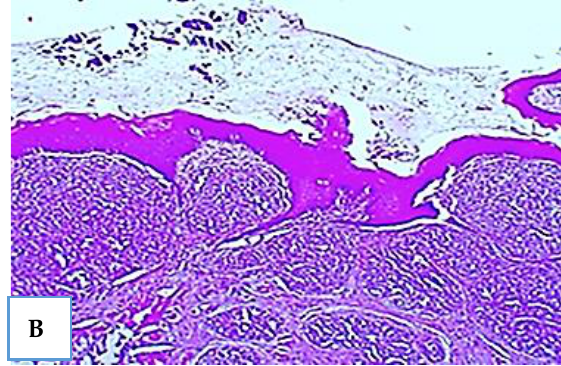
Figure (2-A): Photomicrograph lobular